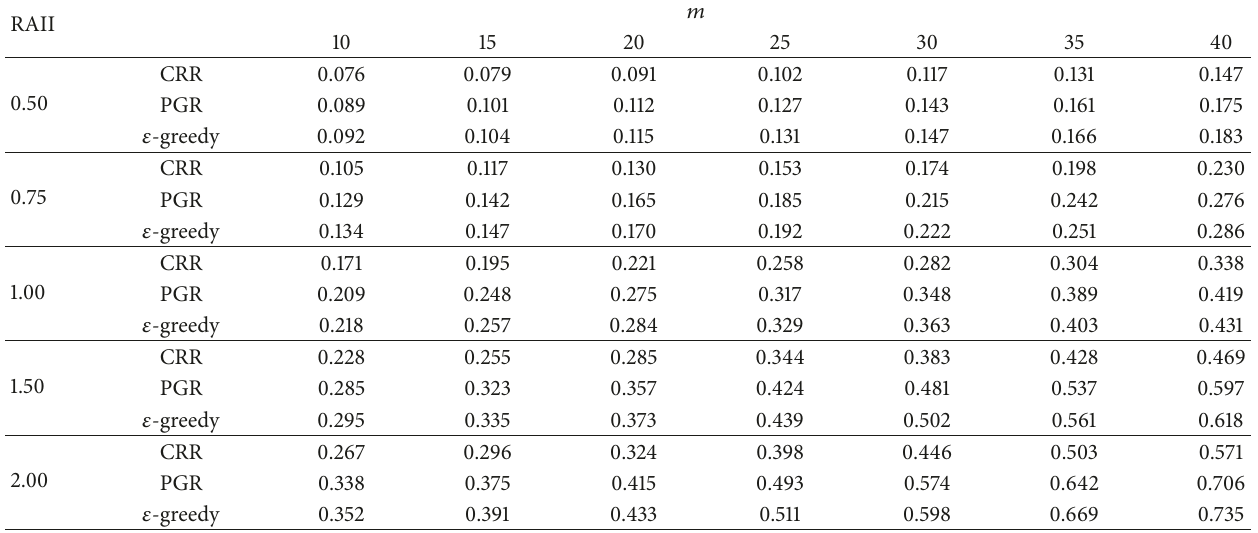
Table 1: The time averaged weighted throughput (AWT) of the extensive test problems.